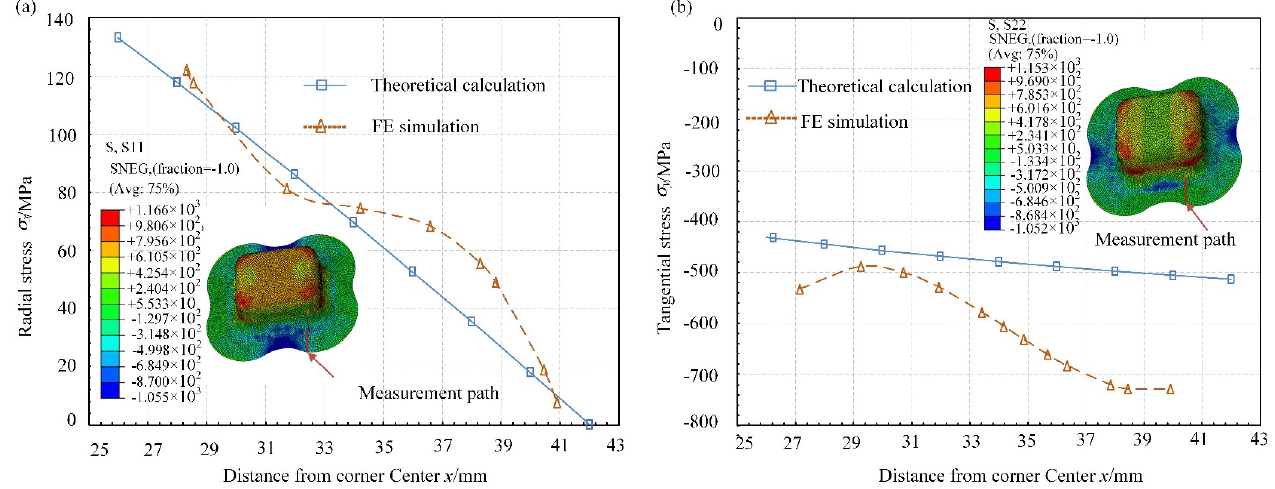
Figure 9. Stress distribution in straight-edge area. ( a ) Radial stress; ( b ) tangential stress.